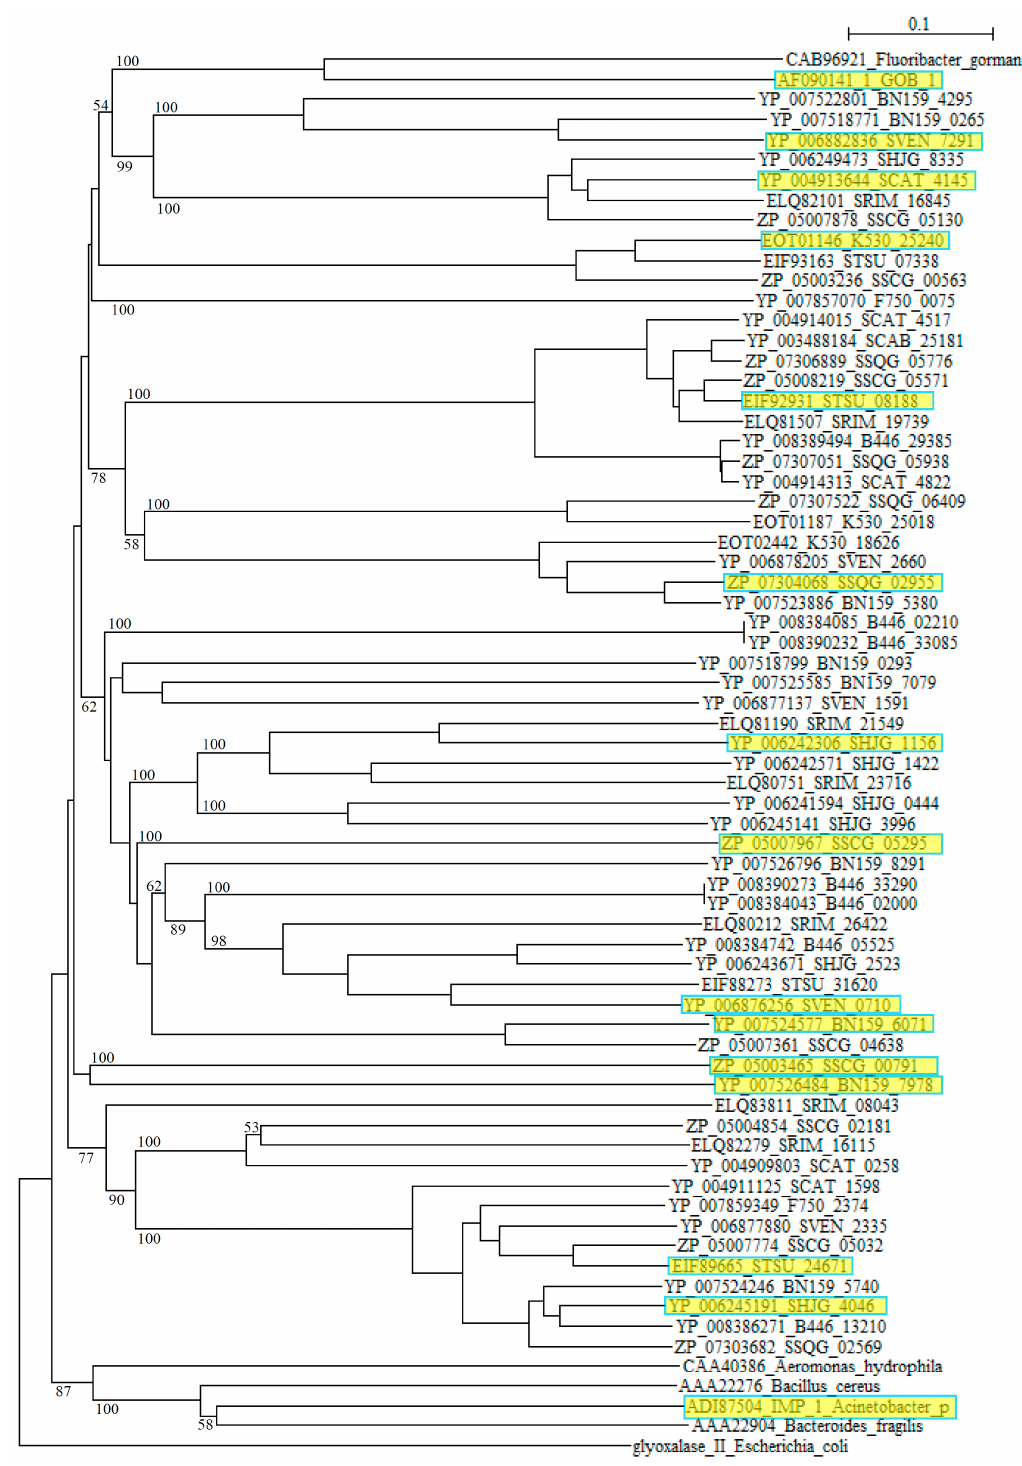
Figure 2. Phylogenetic tree of putative 63 class B β -lactamases on the basis of amino acid sequences. The tree was constructed by using ClustalX 2 [88] and Escherichia coli glyoxalase II (CDZ19109) as outgroup. β -Lactamases from Fluoribacter gormanii (CAB96921), Elizabethkingia meningoseptica GOB-1 (AF090141_1), Aeromonas hydrophila (CAA40386), Bacillus cereus (AAA22276), Acinetobacter pittii IMP_1 (ADI87504), and Bacteroides fragilis (AAA22904) were used as reference sequences. The sequences marked with yellow boxes were used for the calculation of molecular distances (Table S4). The bootstrap probabilities are shown at branching